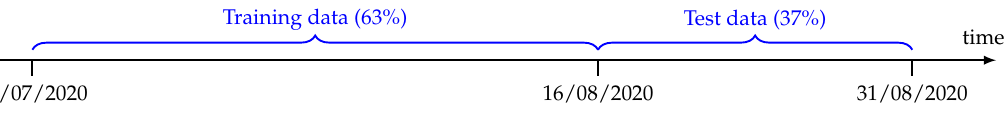
Figure 2. Splitting of train and test